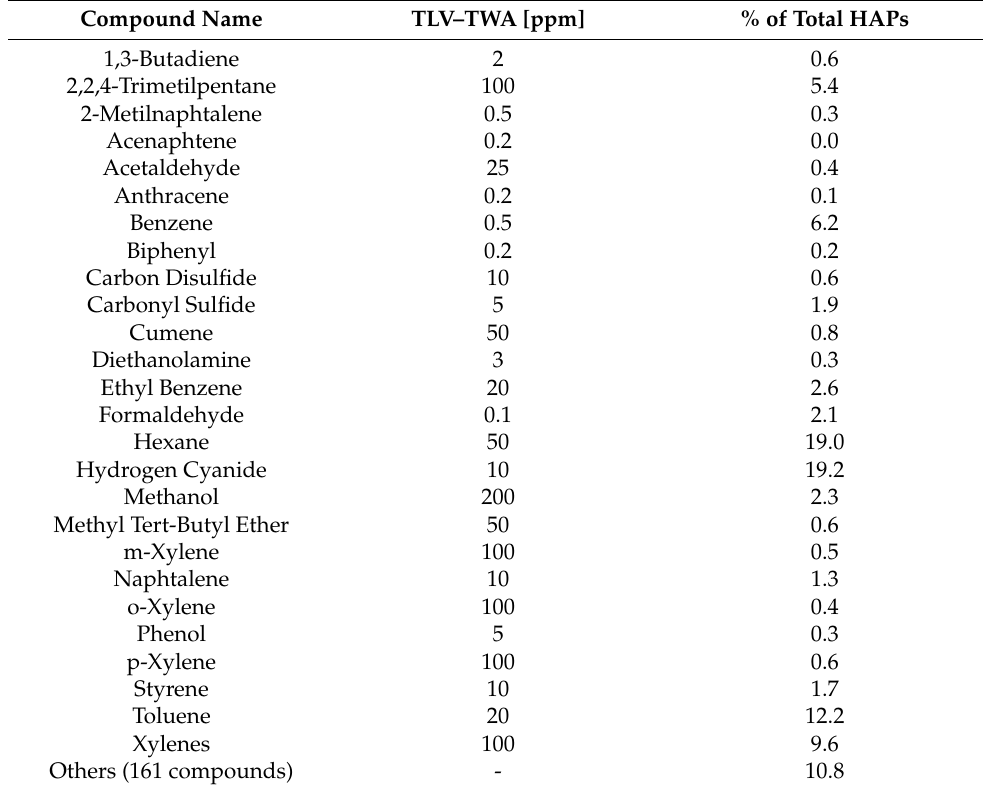
Table 1. List of compounds responsible for almost 90% of total HAP emissions from American refineries with respective TLV–TWA [43,44].